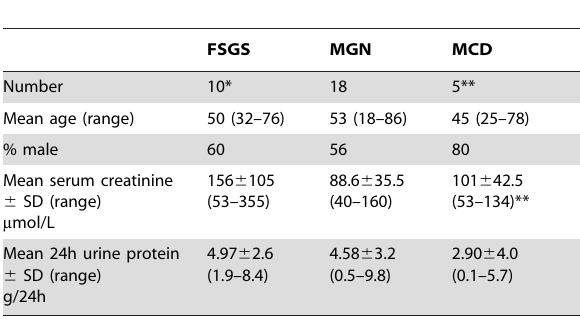
Table 4. Patient characteristics – European Renal cDNA Bank glomerular disease